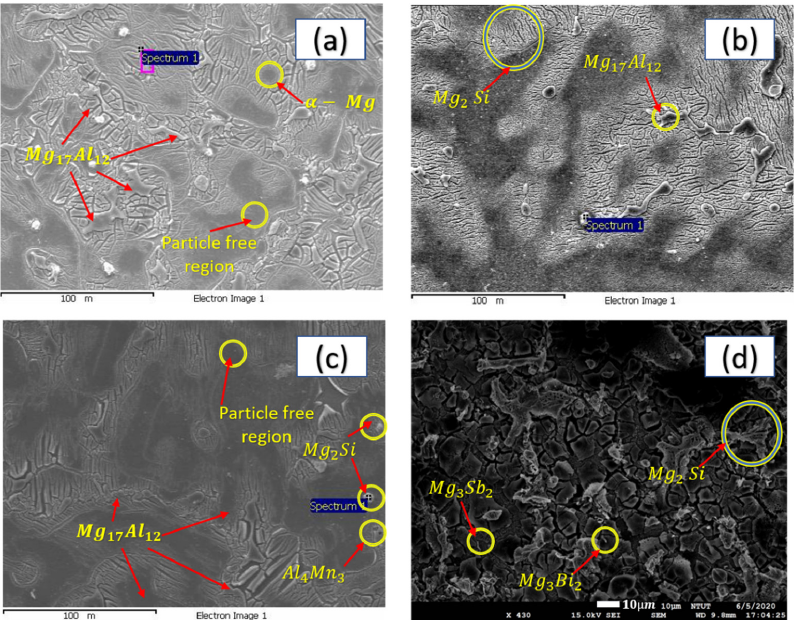
Figure 9. SEM images of ( a ) pure AZ91 matrix, ( b ) AZ91 + 0.5 wt.% SiCp, ( c ) AZ91 + 1 wt.% SiCp and ( d ) AZ91 + 0.5 wt.% SiCp + 1 wt.% Bi + 0.4 wt.% Sb.